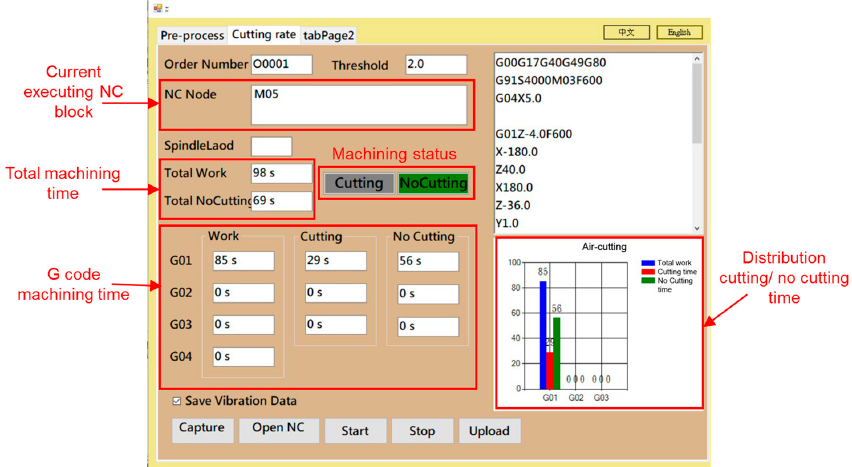
Figure 3. Air cutting monitoring human machine interface (HMI).